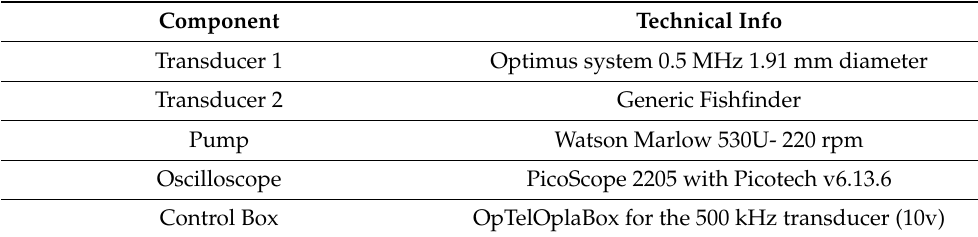
Figure 1. Setup used for the bench-scale experiments. Table 1. Characteristics and types of devices used in the setup.